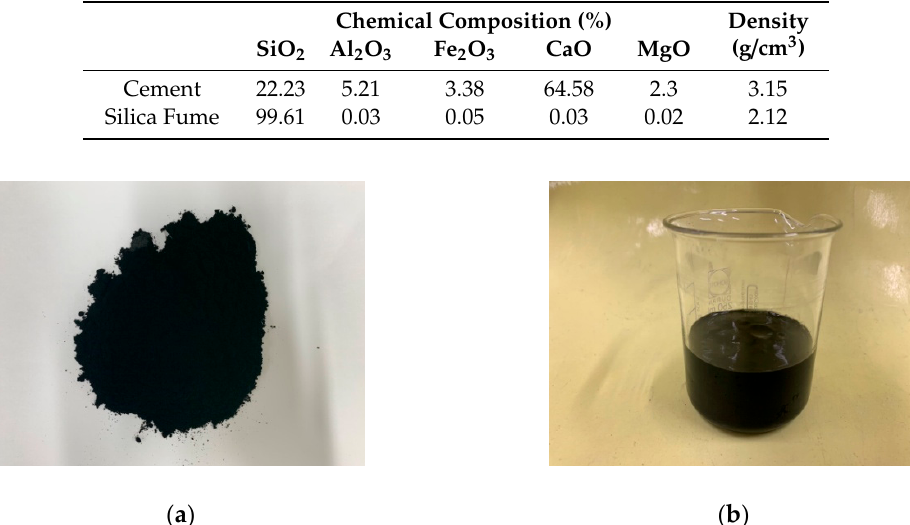
Table 1. Chemical compositions and densities of cement and silica fume.